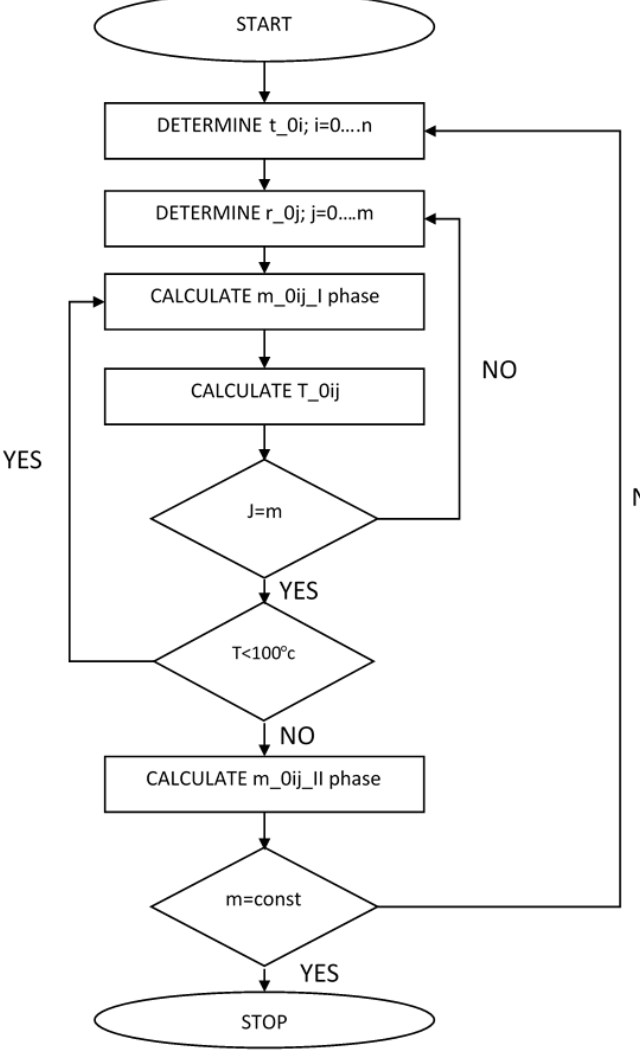
Figure 15. Algorithm diagram of the simulation model.